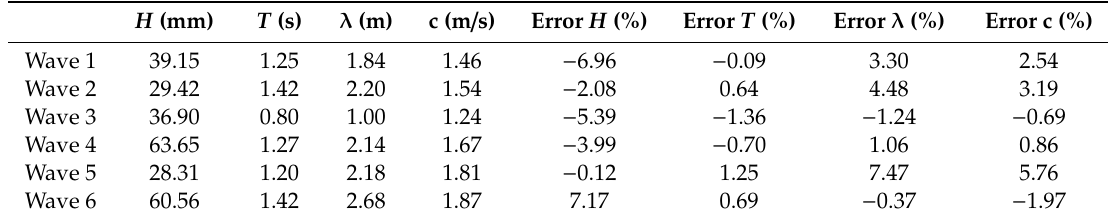
Table 3. Results obtained from the simulations carried out using the k- ε turbulence model and relative errors with respect to the experimental values of the incident wave.